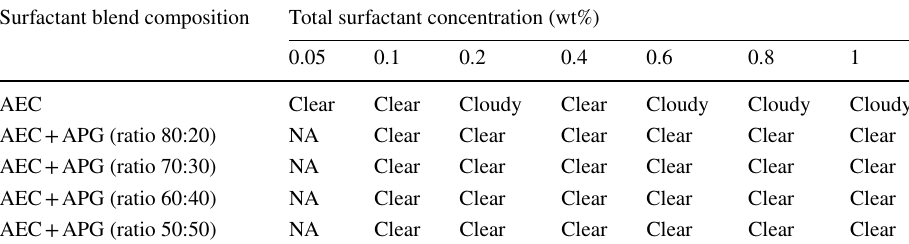
Table 5 Summary result for surfactant solubility at various overall concentrations and blending ratio after day 60 days at 80 °C